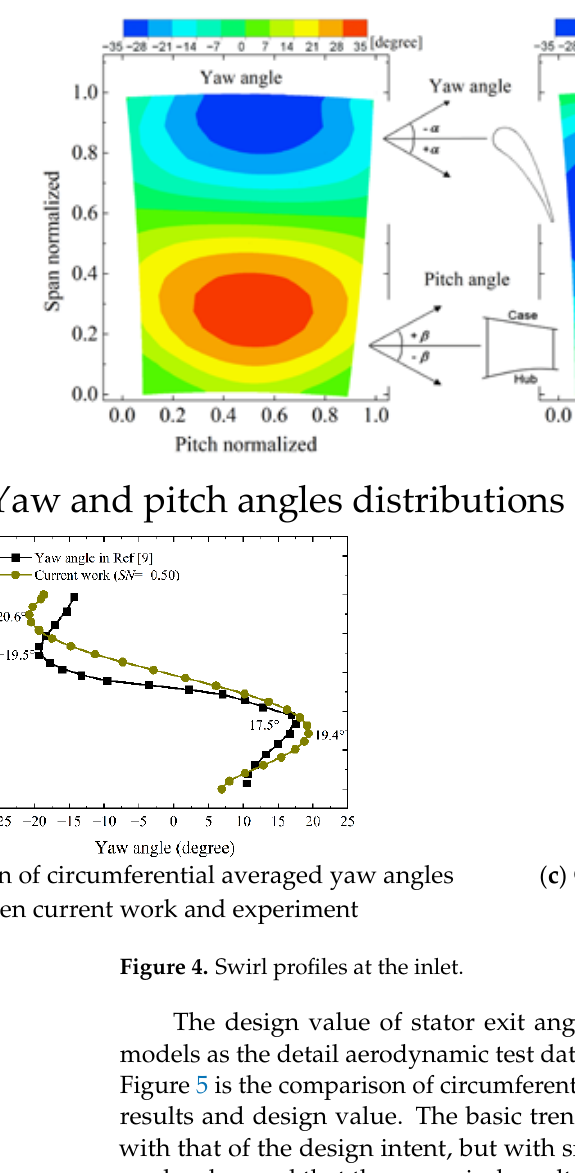
Figure 5. Circumferential averaged vane exit angle. Due to the lack of experimental data in term of heat transfer on GE-E3 HP turbine, the further examination for turbulence models used the experimental results of the MarkII vane [29], which is with ten radial internal cooling channels and has extensive experi- mental data under the realistic turbine operation conditions. Steady conjugate heat trans- fer (CHT) simulations were performed under the experimental condition No. 5411 with the inlet Mach number equal to 0.19. The CHT mesh of the Mark-II vane was generated by POINTWISE, as revealed in Figure 6. The turbulence models checked were the same as before and the grids adjustments were also conduced to adapt to them. The measured vane surface pressure and temperature were utilized to examine the turbulence models.